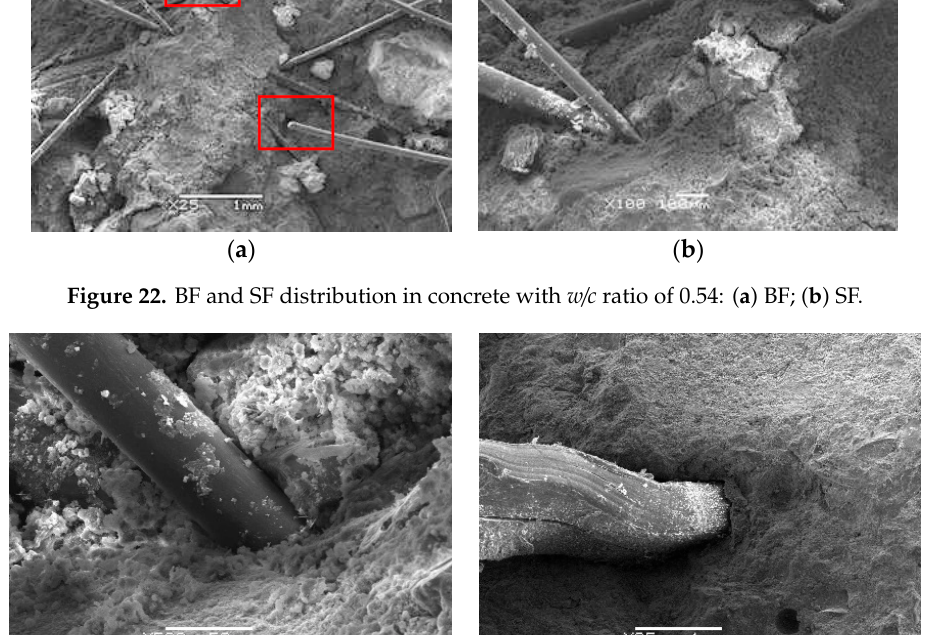
Figure 23. Interface between mortar and fibers: ( a ) Interface between mortar and BF of BC; ( b ) Interface between mortar and SF of SC.